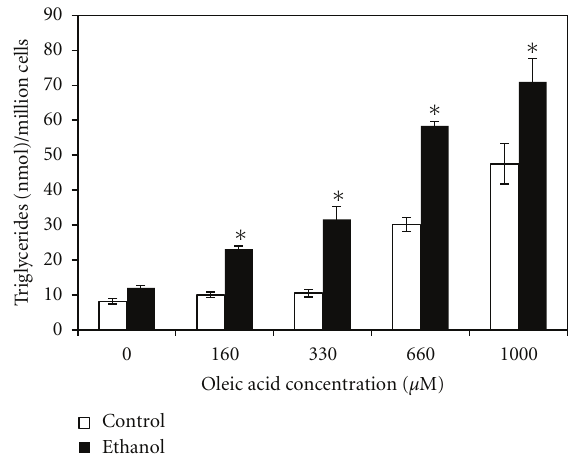
Figure 1: Ethanol-induced triglyceride accumulation in oleate- treated WIF-B cells. Cells were treated for 48hr with or without 25mM ethanol in presence of di ff erent concentrations of oleic acid. Values are means ± SEM ( N = 4). ∗ Significantly di ff erent ( P < 0 . 05) from control group.